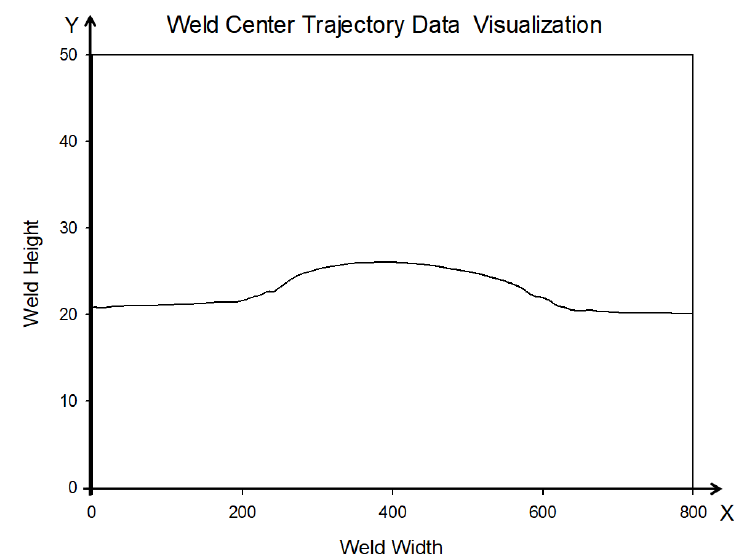
Figure 4. Visualization of the trajectory data for the weld